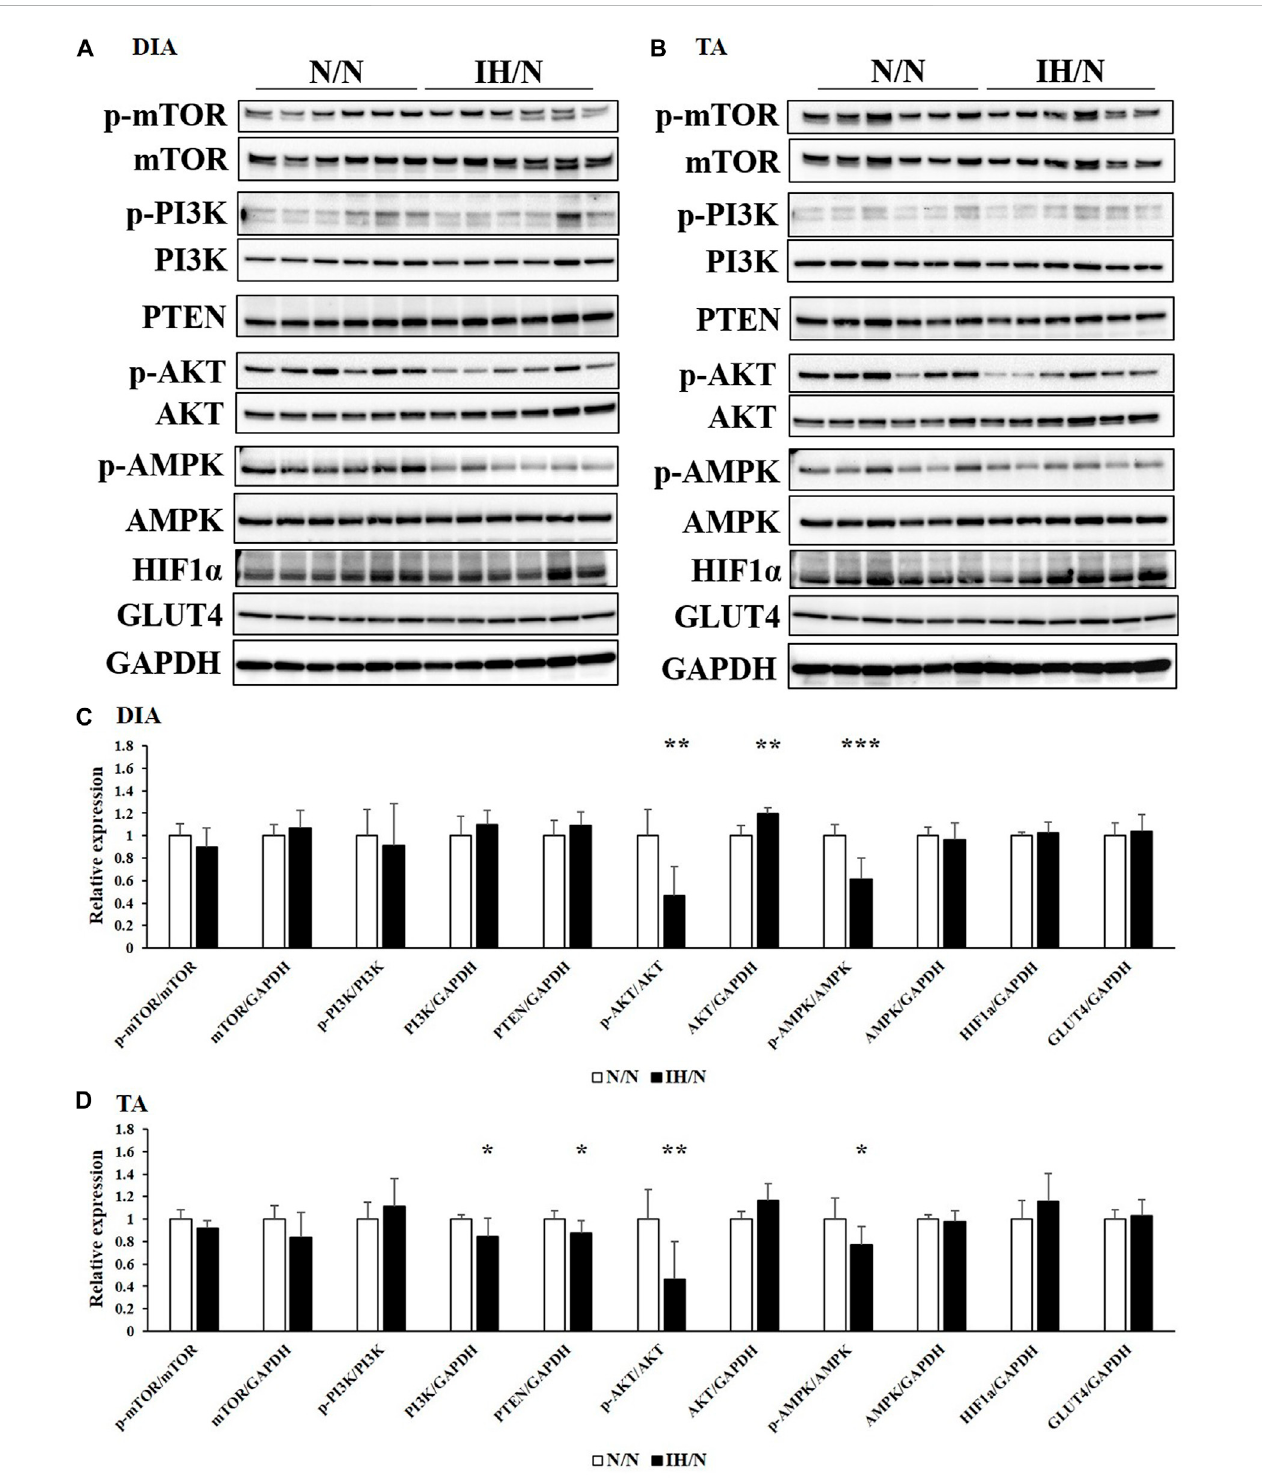
FIGURE 6 Western blot analysis of proteins involved in glucose and lipid metabolism in the DIA and TA muscles. Western blots were performed on six individual samples to quantify the levels of mTOR, PI3K, AKT, AMPK, PTEN, and HIF1 α in the (A) DIA, and (B) TA muscles. Graphs represent the ratio between the phosphorylatedformsofmTOR,PI3K,AKT,andAMPK,andthetotalamountofeachtargetprotein.Relativeexpressionlevelsofeachproteinwerenormalized to the level of GAPDH expression. Expression levels are shown with those for (C) DIA, and (D) TA muscles from the N/N group set to 1 * p < .05, ** p < .01, *** p <